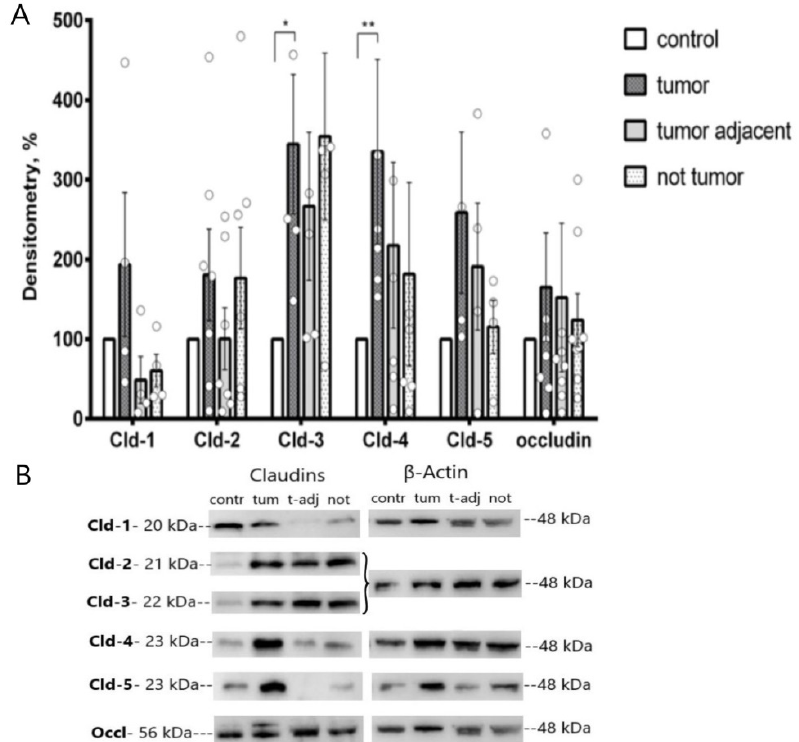
Figure 1. Western blot analysis of TJ protein expression in rat colon after chronic DMH administration. ( A ) densitometric analysis revealed increased claudin (Cld)-3 and -4 in tumor vs. control ( n = 4 and n = 5, respectively). The values were normalized to β -actin as protein loading control. The number of symbols corresponds to the number of samples. ( B ) representative immunoblots, including stripped blots (the data for Cld-2 and Cld-3 had the same control. Cld-3 was determined after stripping of Cld-2, then β -actin was analyzed). Data (mean ± SEM); * p < 0.05, ** p < 0.01, Mann–Whitney